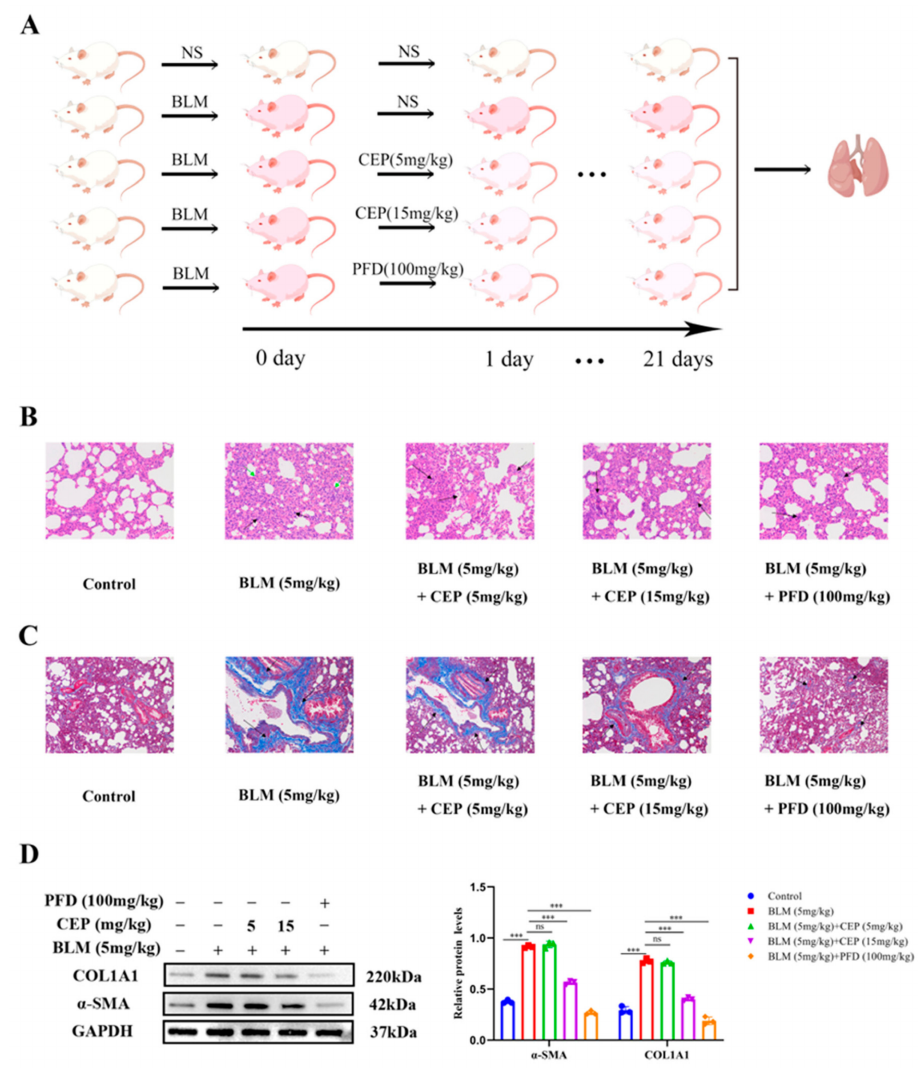
Figure 1. CEP attenuates BLM-induced collagen deposition in rats. ( A ): Experimental process in vivo (By Figdraw), n = 6. ( B ): Lung tissue structures inflammatory expression visualized using hematoxylin and eosin (H&E) staining. alveolar septa and alveolar collapse had thickened (Green arrow). high granulocyte infiltration (Black arrow). Scale bar: 100 µ m. ( C ): Collagen deposition in lung tissues visualized using Masson’s trichrome staining. blue collagen fibers (Black arrow). Scale bar: 100 µ m. ( D ): Protein levels of α -SMA and COL1A1 measured with Western blotting. ns: no statistical difference, and *** p <